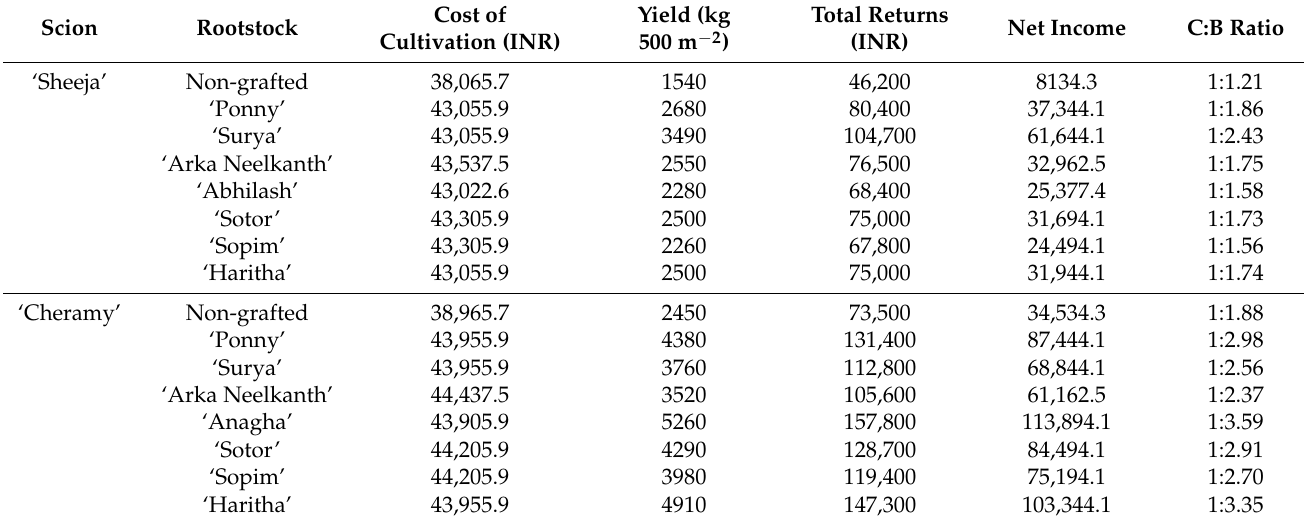
Table 9. Economics of grafted and non-grafted cherry tomato